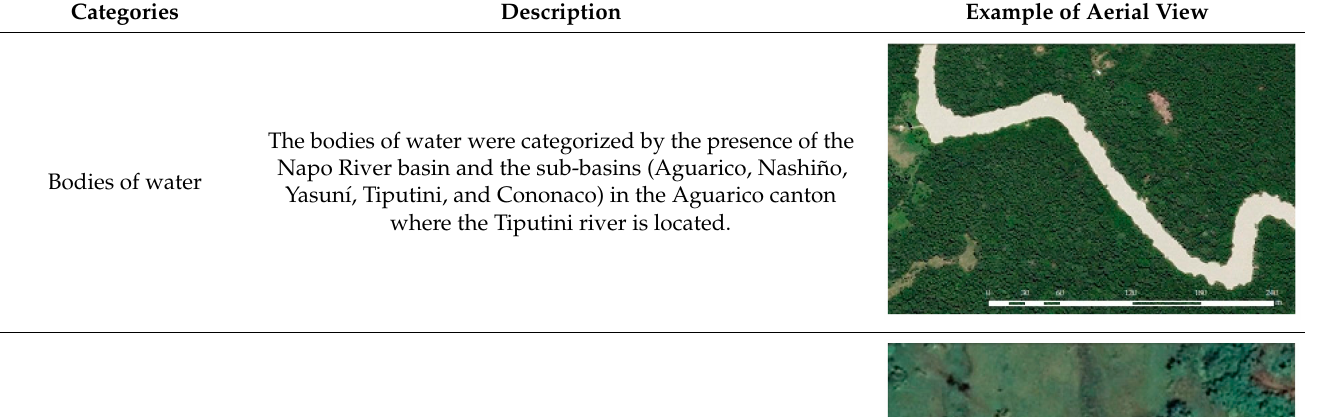
Table 2. Land use and land cover classification scheme in the ITT Oil Block of the Ecuadorian Amazon region.